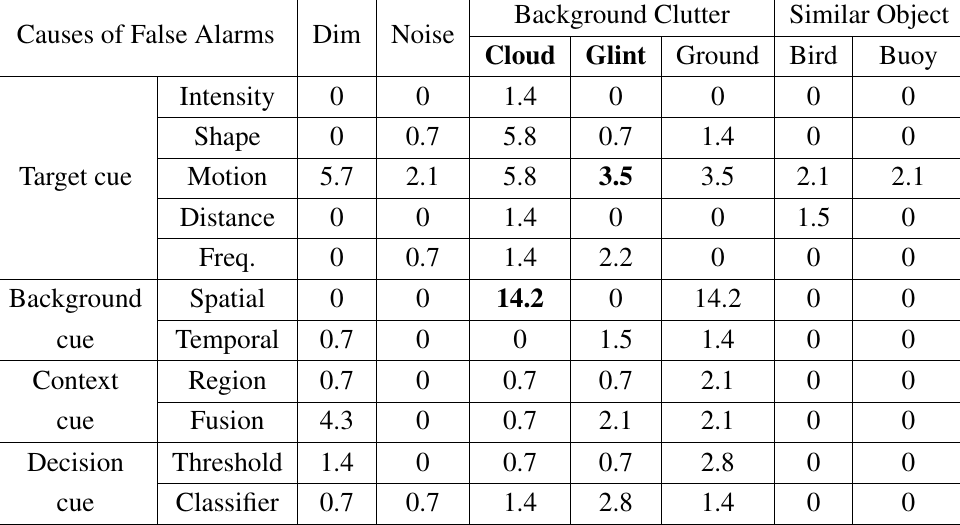
Table 1. Statistics of research papers in terms of the causes of false alarms and the methods of overcoming them